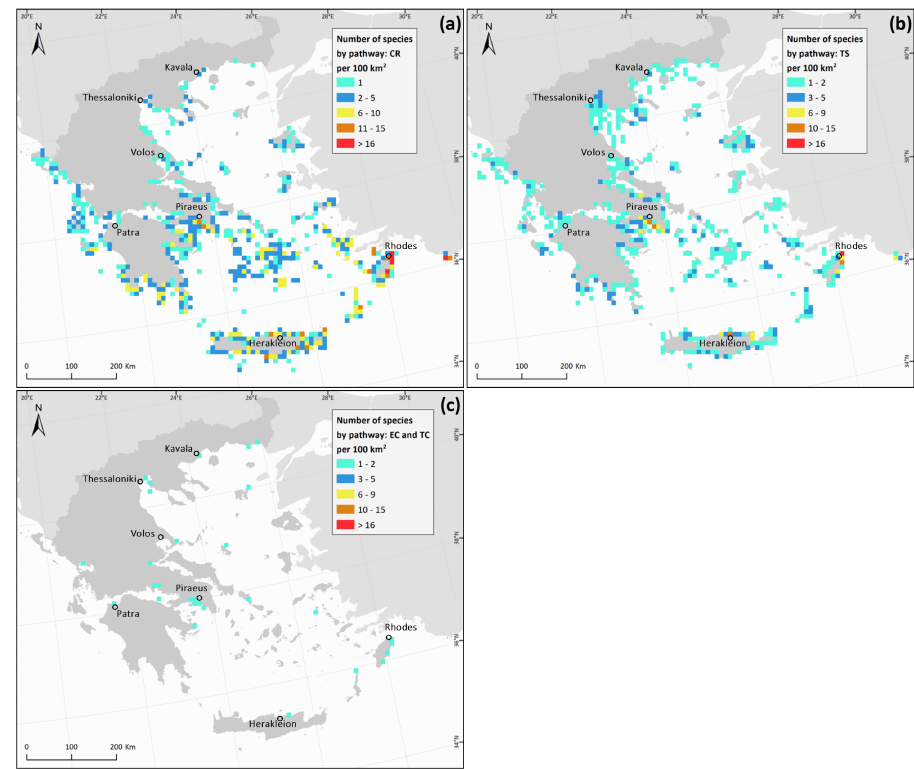
Figure 5. Map of the Greek Seas depicting the total numbers of ICAS according to their primary introduction pathways into the Mediterranean: ( a ) via corridors—CR, ( b ) as transport stowaways— TS, ( c ) via escape from aquaculture or mariculture confinement—EC—and as transport contaminants on animals—TC. Grid cells were produced using the 10 × 10 km EEA reference grid. Of the 5478 records, only 42.9% specified the habitat type in which the ICAS were recorded. Of the 2352 records reporting habitat type, 58.0% referred to rocky substrata, 23.0% to mobile substrata (i.e., including mud, sand, and small pebbles), 8.6% to mixed substrata (combining rock with sand or seagrasses), 3.8% to marine caves, 3.2% to seagrasses, and 2.1% to artificial substrata, while the water column and coastal lagoons accounted for less than 1% of records each. The habitat types with the highest numbers of species were the mobile (37 species) and rocky substrata (35), followed by mixed substrata (24), artificial substrata and marine caves (17 species each), seagrasses (12), the water column (2), and coastal lagoons (2) (Figure 6a).